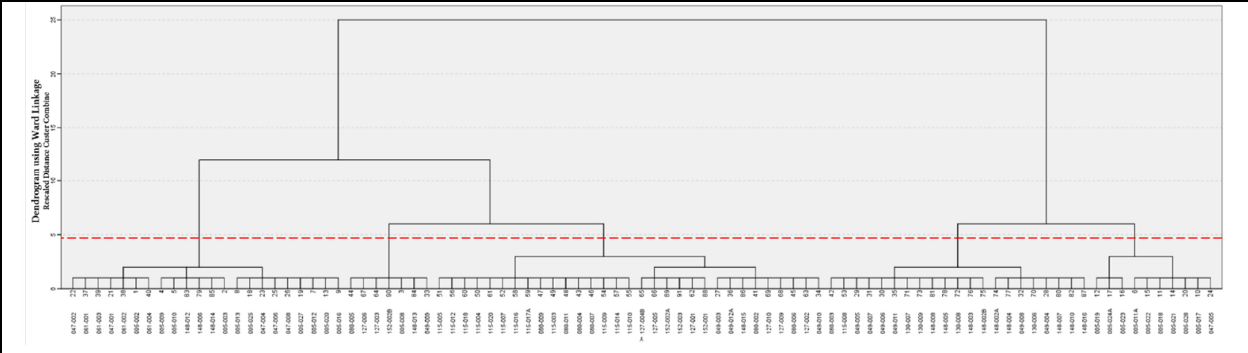
Figure A2. Dendrogram. The red line indicates the cut-off point (with 5 clusters, stage 86).